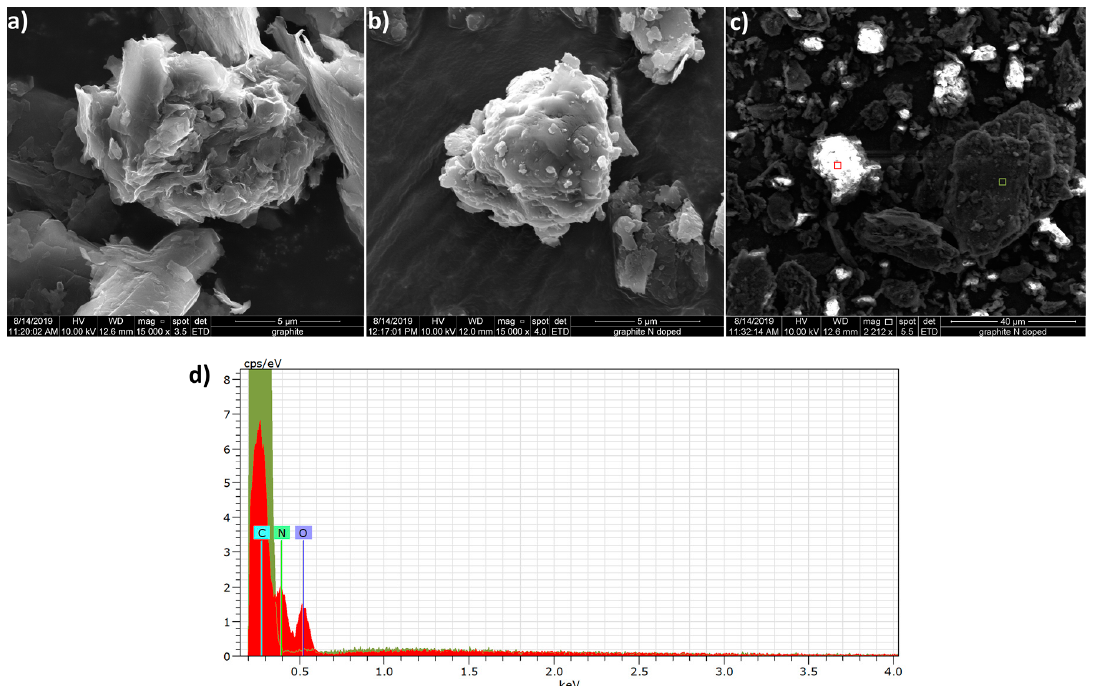
Figure 1. SEM/EDS of graphite and N-doped graphite. SEM images depict untreated ( a ) and N-doped graphite ( b ) particles. An SEM image of N-doped graphite obtained without prior application of Au/Pd conductive coating ( c ) exhibits areas of high surface charging (bright spots). Red and green boxes correspond to areas analyzed by EDS. EDS analysis ( d ) shows the absence of oxygen and nitrogen in an area of low surface charging (green shaded spectrum corresponding to the green box in ( c ) and the presence of these atoms in an area of high surface charging (red shaded spectrum corresponding to the red box in ( c )).